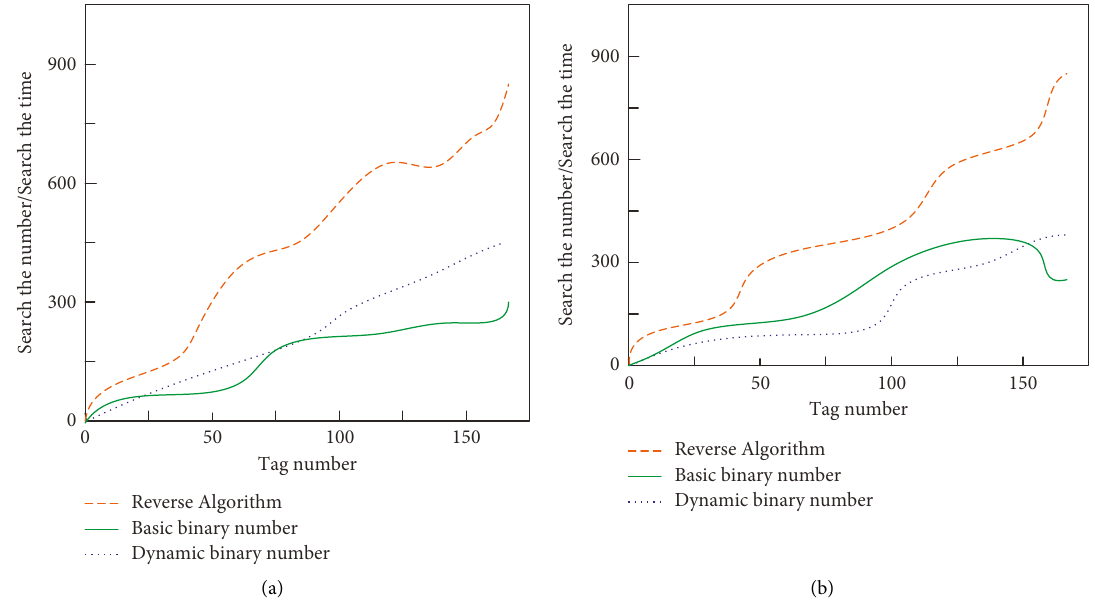
Figure 9: The stability index of the three algorithms for the platform and the change of the RFID accuracy: (a) variation of the stability index with actuarial calculations and (b) variation of the RFID accuracy with actuarial calculations. Table 4: Classification accuracy based on different loss functions.